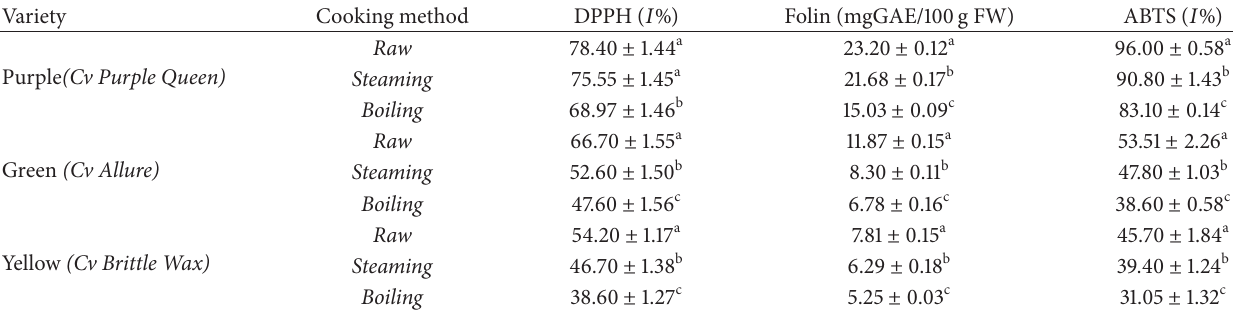
Table 1: Effect of different cooking methods on total phenolic content and antioxidant capacity of three green beans varieties. Variety